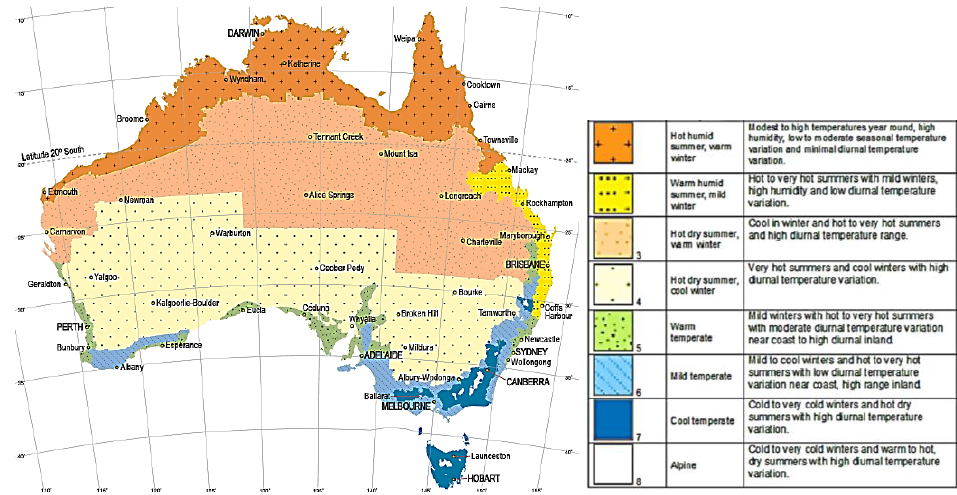
Fig. 1. Major climate zone in Australia with their features